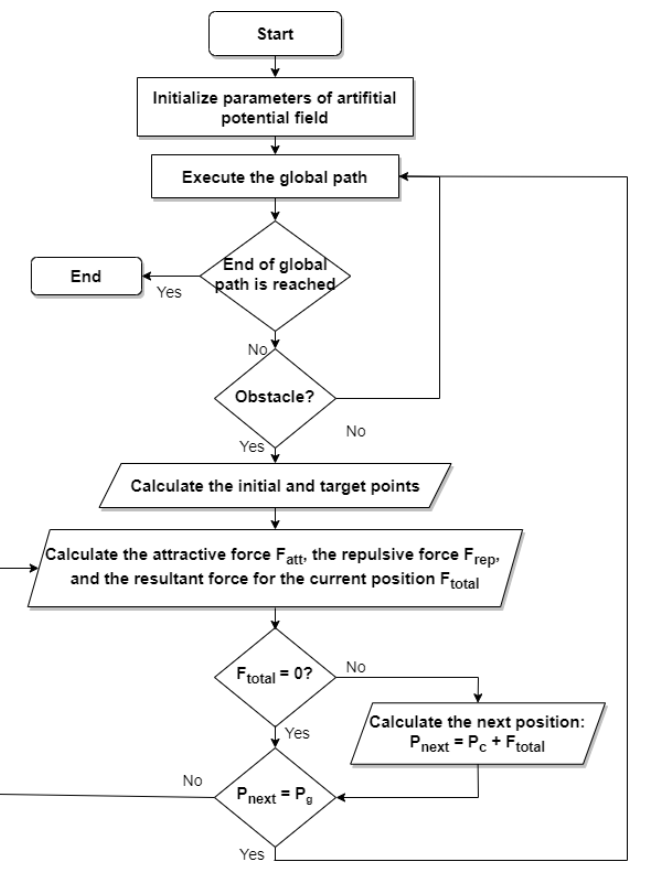
Figure 5. The flowchart of the proposed trajectory re-planning method based on the improved